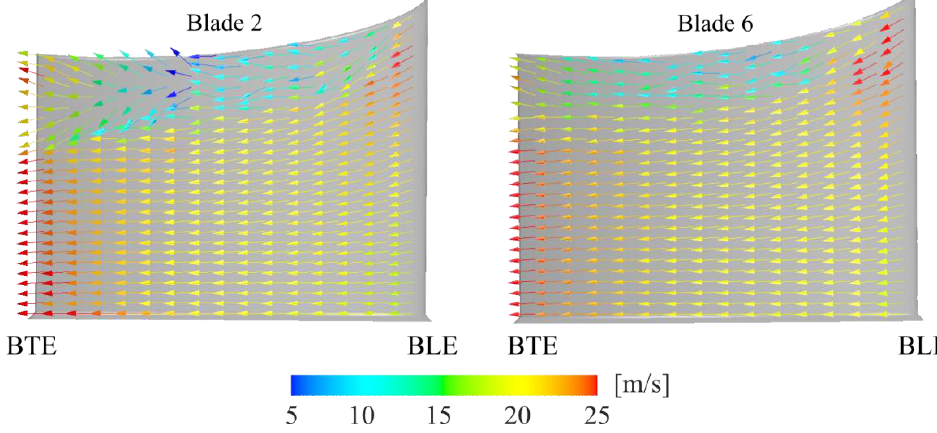
Figure 6. Velocity vectors close to the pressure side of Blades 2 and 6, colored with velocity magni- tudes.